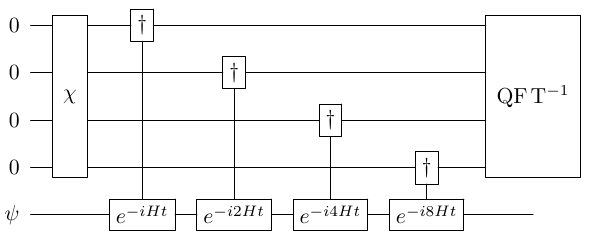
FIG. 4. Four-qubit version of the asymptotically optimal phase estimation